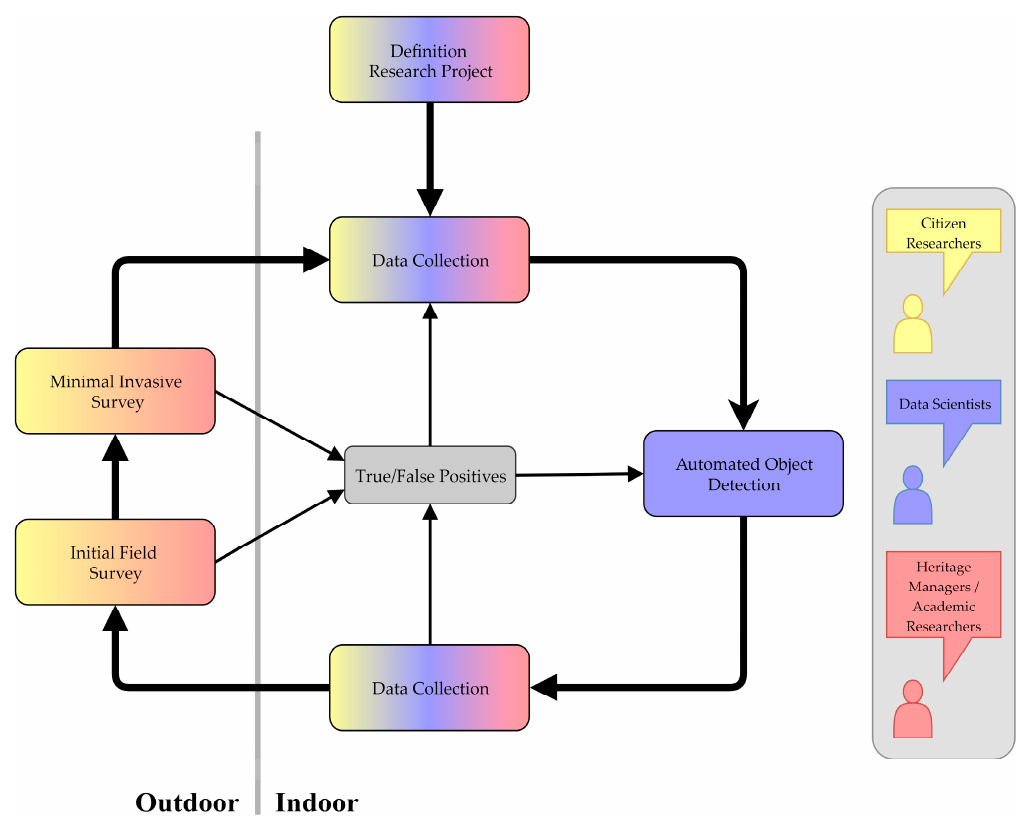
Figure 6. The integrated approach as proposed in this paper with colors depicting the involvement of different interest groups (see box on